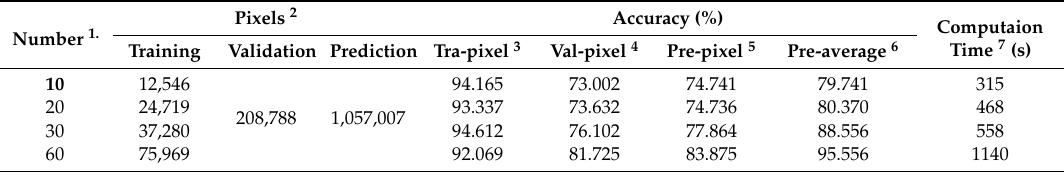
Table 4. Pixel-wise CNN models used to predict pixel-wise spectra and average spectra. Number